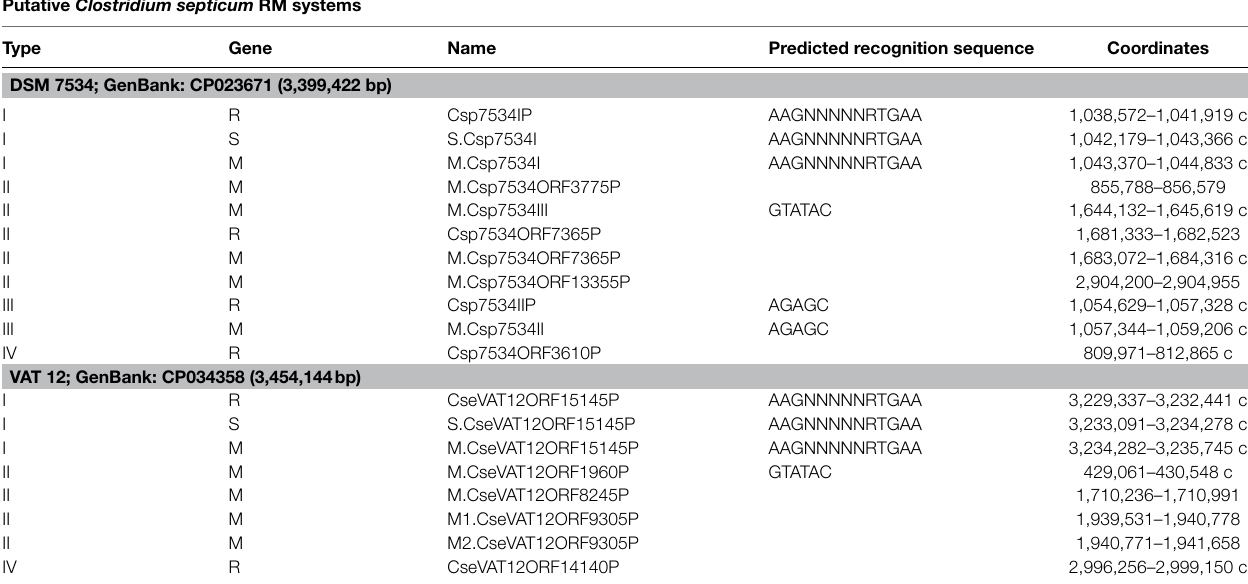
TABLE 4 | Restriction-modification (RM) systems identified in C. septicum genomes RM systems involved, associated rrestriction endonucleases (REases) and methyltransferases (MTases), type/subtype information and recognition sequence they methylate, respectively, for DSM 7534 T and VAT 12 are indicated. Putative Clostridium septicum RM